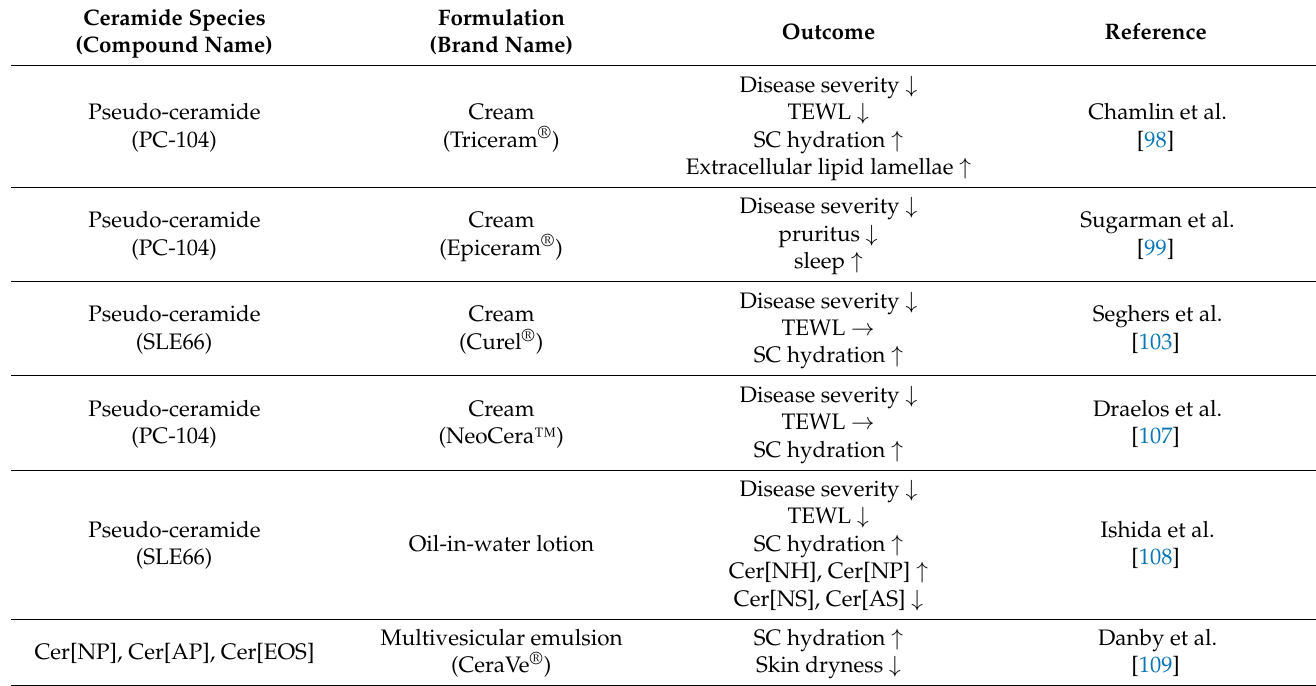
Table 2. Clinical studies examining the effects of ceramide-containing emollients on xerosis and AD. Ceramide